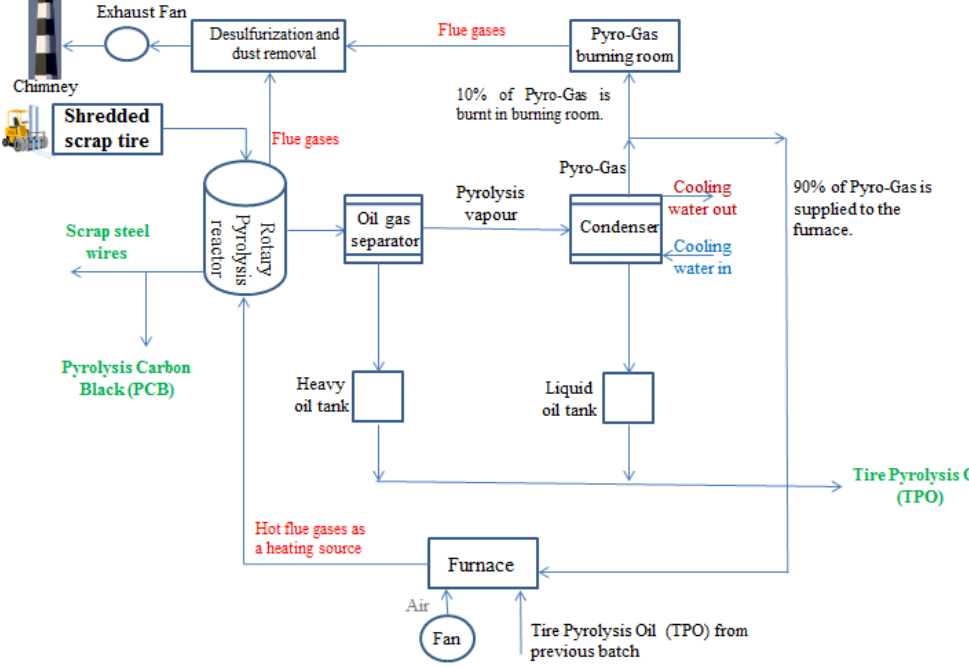
Figure 2. Flow diagram for the tire pyrolysis process.